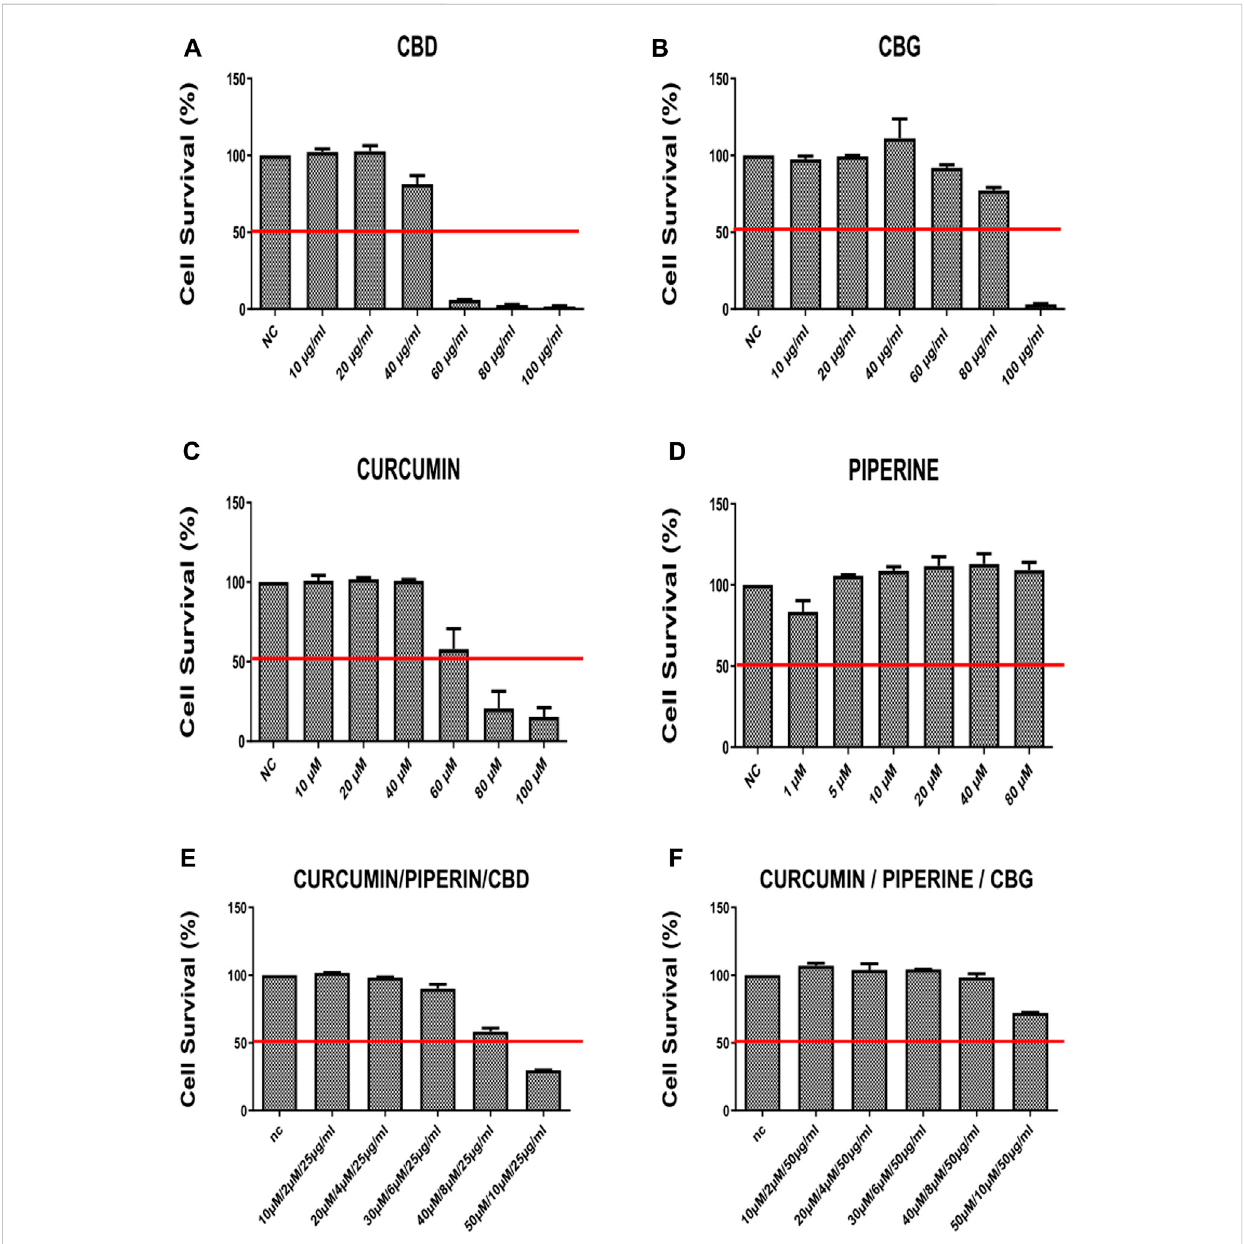
FIGURE 2 The cell survival rates (percent) of HT-29 cancer line 72 h after treatment with (A) CBG (Cannabidiol) (B) CBD (Cannabigerol) (C) Curcumin (D) Piperline (E) combination of curcumin piperline and CBD (F) combination of curcumin piperline CBG. All groups were compared to their corresponding negative